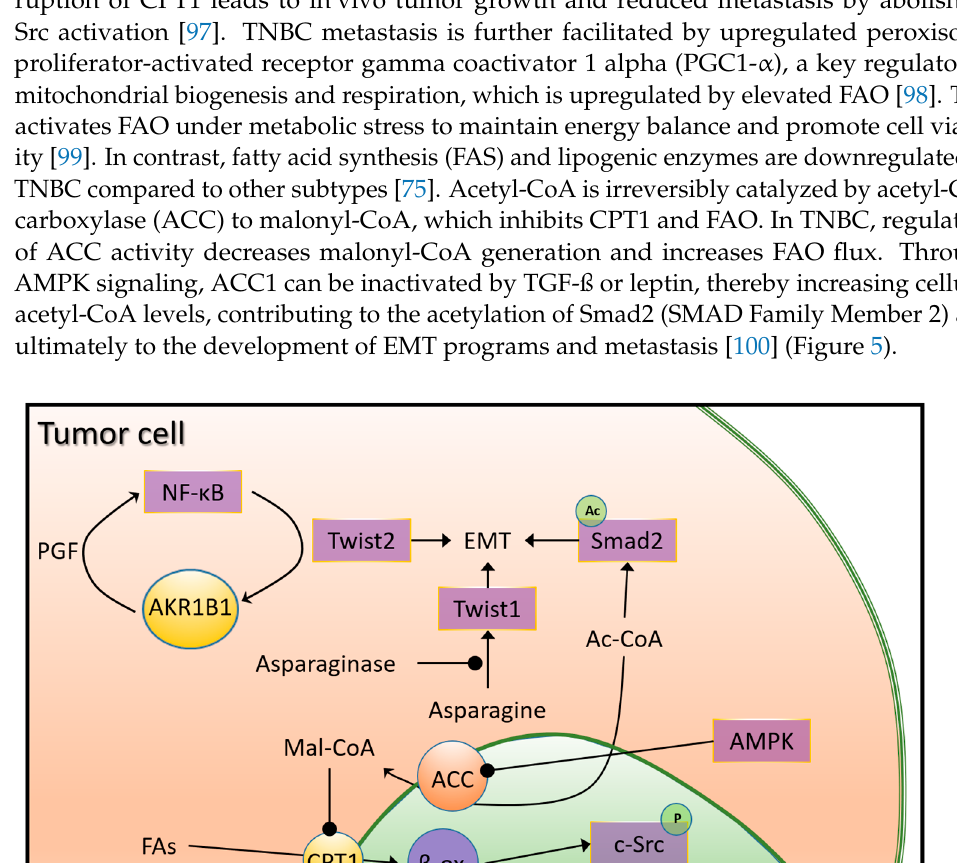
lesterol acyltransferase 1 (ACAT1) were also found in TNBC, leading to elevated choles- terol biosynthesis in the mevalonate pathway [102]. NF- κ B signaling is also activated and supports EMT programs by the upregulation of aldo–keto reductase 1 member B1 (AKR1B1) by the positive feedback of Twist2 activation [103] (Figure 5). 5. Epigenetic Changes in TNBC While genomic changes of TNBC include mutations, copy number variations, and genetic rearrangements, TNBC is also characterized by epigenetic signatures, including changes in DNA methylation and histone remodeling [104]. These epigenetic modi fi ca- tions either silence or activate genes that were previously described in TNBC. In addition, recent evidence supports epigenetic regulation of extracellular matrix alterations in TNBC. This reinforces the importance of epigenetic mechanisms, which play a role in the pathogenesis, maintenance, and resistance to therapy [105]. For example, TNBC metasta- sis could be inhibited by Fbxo22 (F-box protein 22) through ubiquitin modi fi cation of KDM5A (Lysine Demethylase 5A) and regulation of H3K4me3 demethylation [106]. Ge- nome- and transcriptome-wide analyses in TNBC show the importance of histone H3 pro- line 16 hydroxylation (H3P16oh) in the regulation of mammalian gene expression, and DKK1 (Dickkopf-related protein 1), a negative regulator of the Wnt pathway, is repressed via the EGLN2 (Egl-9 family hypoxia inducible factor 2)-H3P16oh-KDM5A pathway to promote Wnt/ β -catenin signaling [107]. An increased level of the long non-coding RNA LINC01559 in TNBC is associated with tumor growth and lung metastasis in a xenograft model via increasing the expression of oncogenes [108].